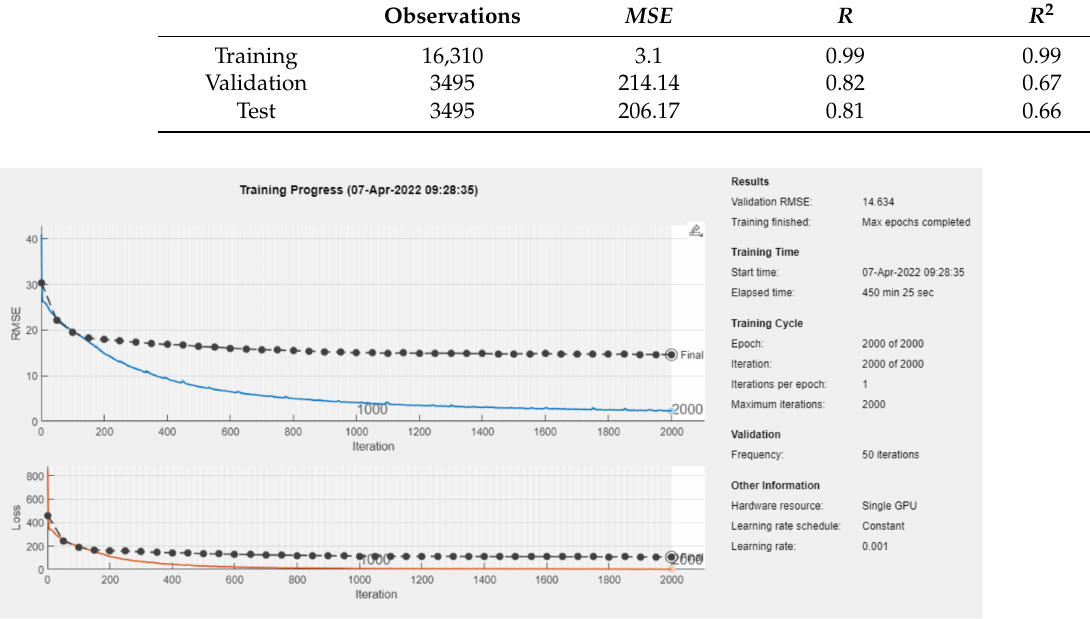
Figure 9. Training progress of the